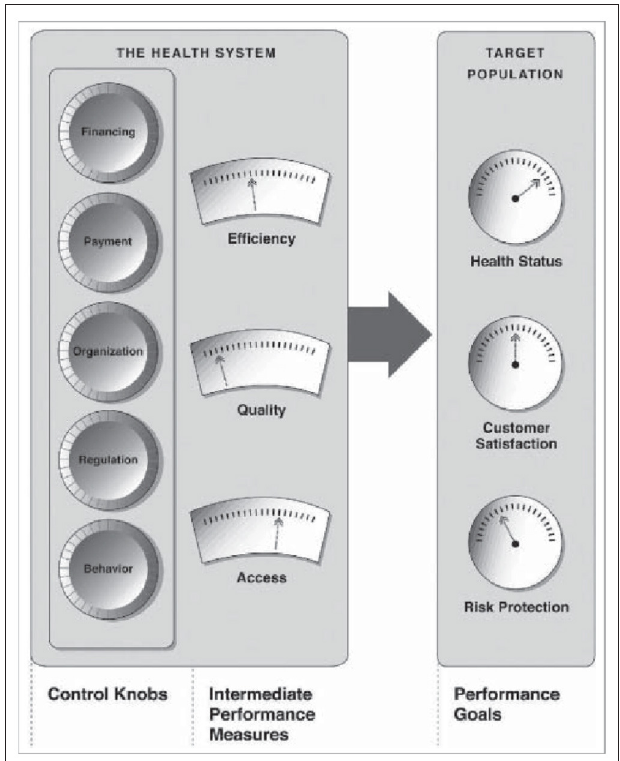
FIGURE 1 | Control Knobs Framework